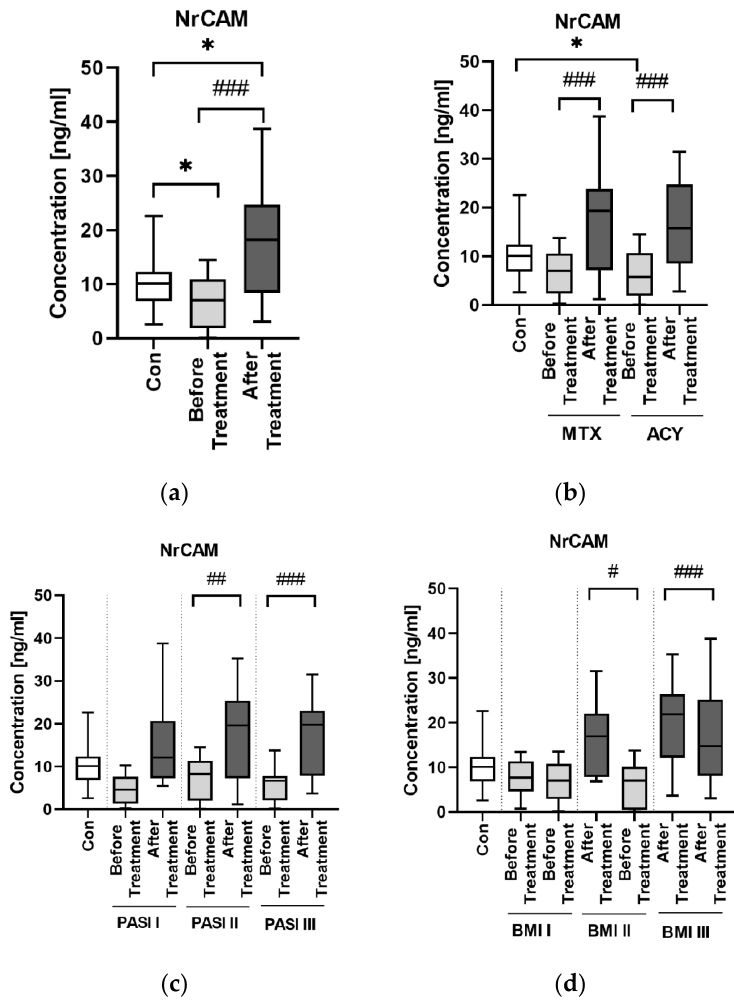
Figure 5. Serum NrCAM in psoriasis patients before total therapy ( a ), both drugs separately ( b ) and with regard to PASI ( c ) and BMI ( d ) subdivision. * — means the existence of statistically significant difference between patients single group compared to controls with p < 0.05; #/##/### — means the existence of statistically significant difference between patients before and after the treatment with p < 0.05/ p < 0.01/ p < 0.001.